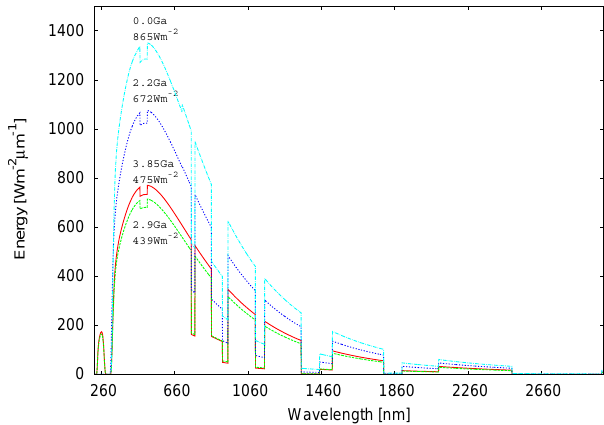
Figure 2. Calculated solar spectra at Earth’s surface at particular dates since present assuming the standard solar evolutionary model and using the best available data for the atmospheric gasses, their densities, and surface temperature. The total integrated (over all wavelengths) energy flows midday at the Equator are given below the